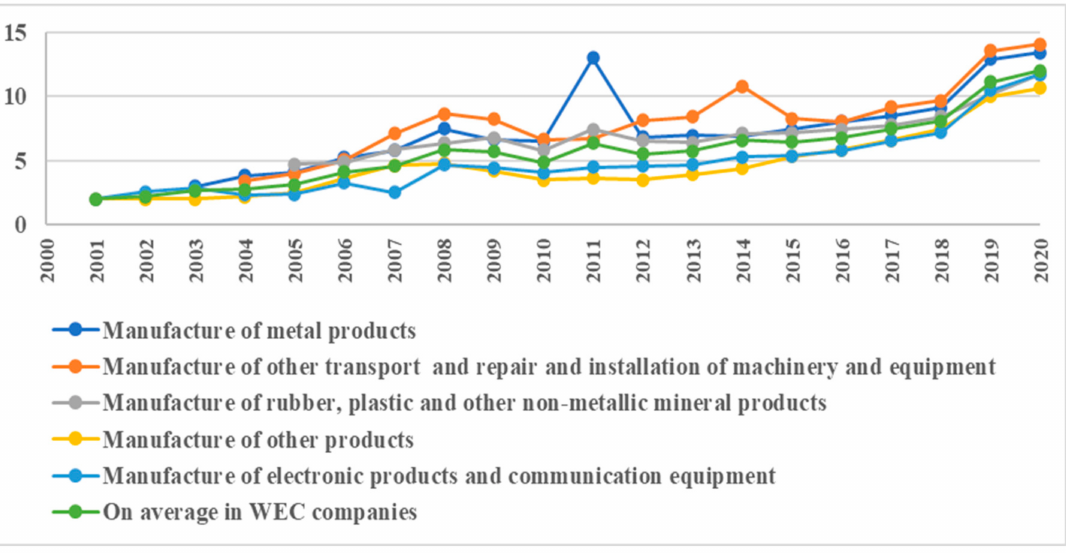
Figure 8. Wages (and salaries),